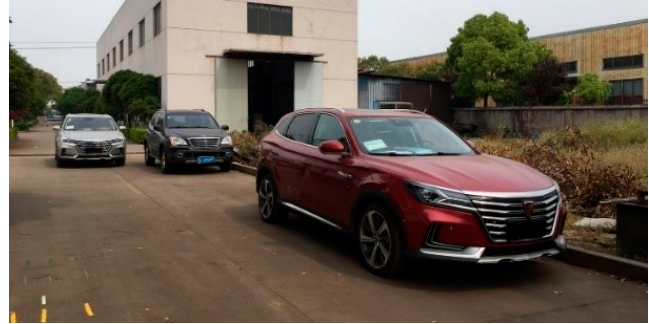
Figure 24. Parking Scenario of Automatic Parking Test.